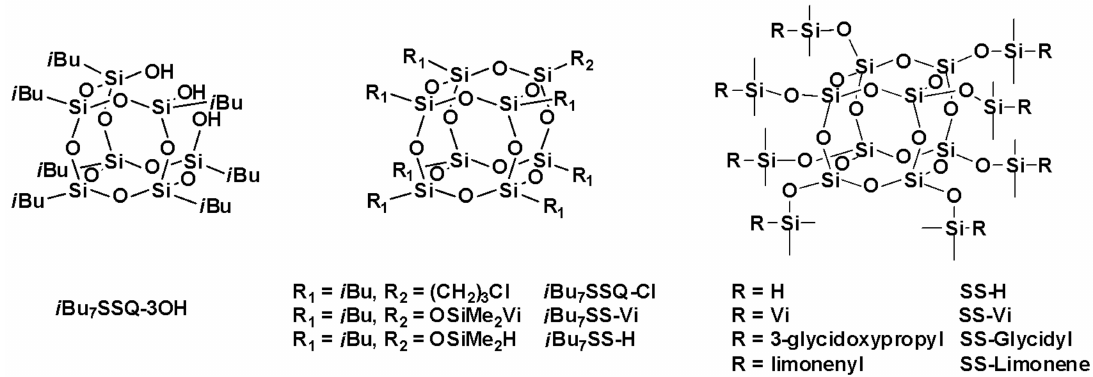
Figure 1. Structures of the cage siloxane compounds studied in this